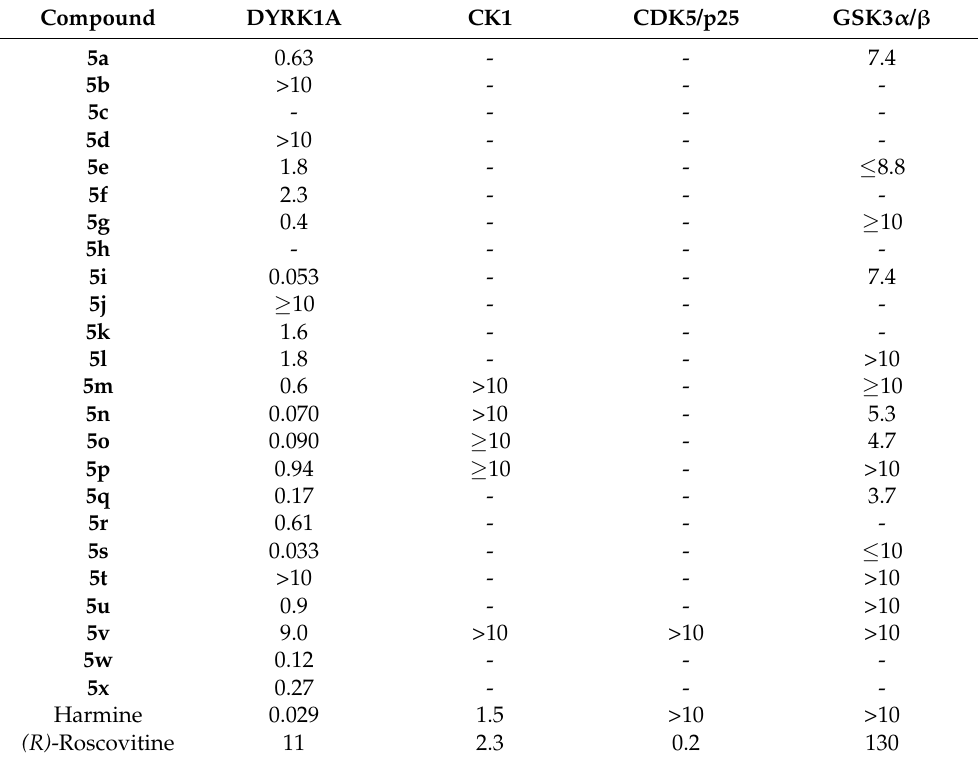
Table 5. Effects of the (5 Z ) 2-amino-5-arylidene-1,3-thiazol-4(5 H )-one derivatives 5a – x on the catalytic activity of four purified protein kinases a